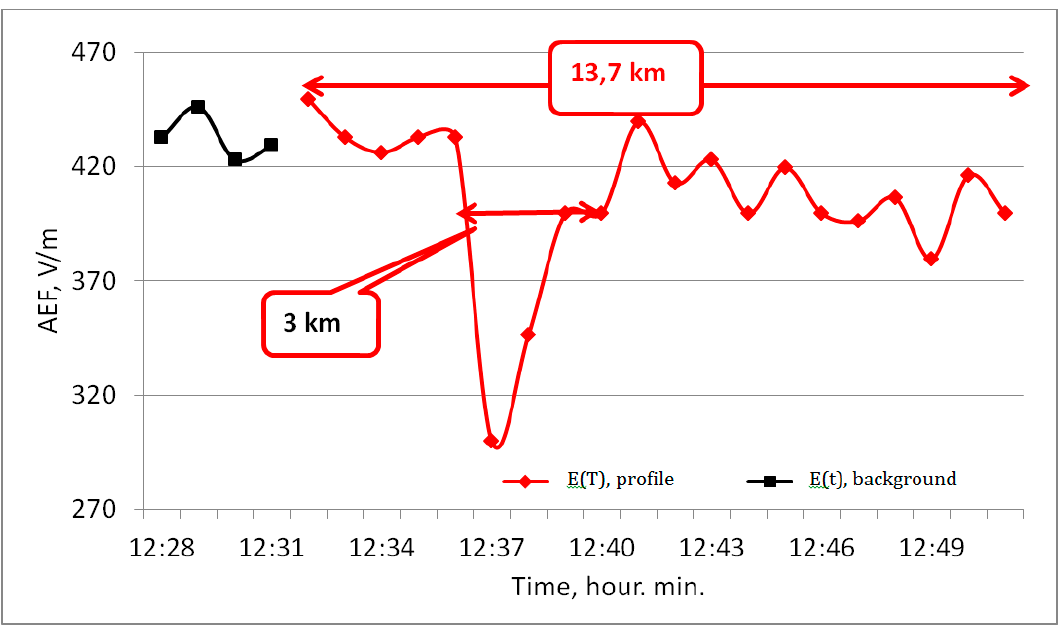
Figure 3. Variations of AEF over the zone of sharp increase in the thickness of sedimentary rocks .